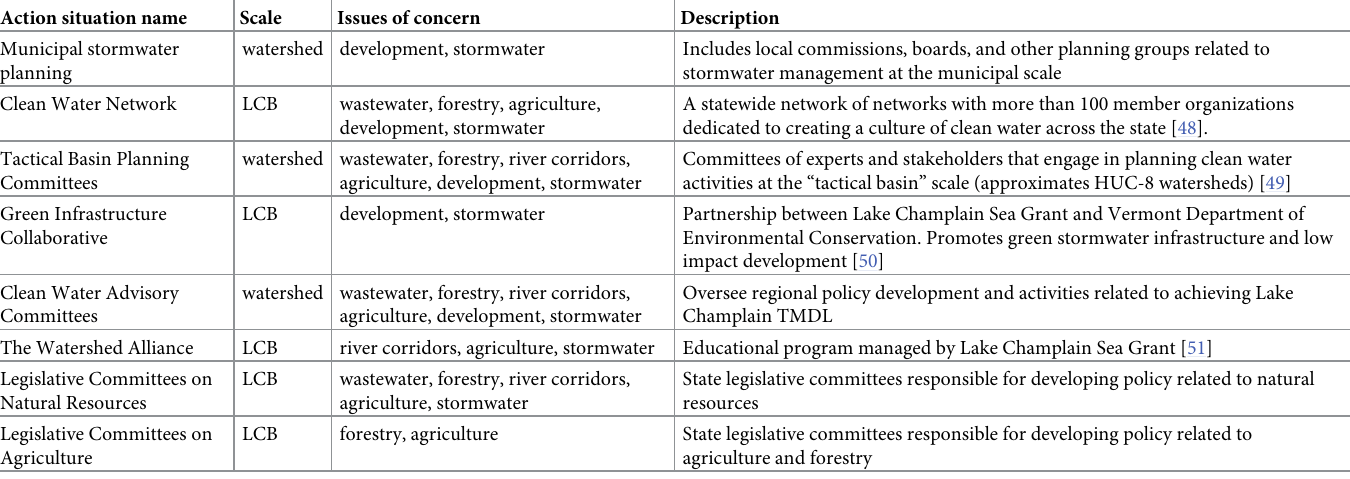
Table 1. Eight action situations related to water quality management in the Lake Champlain Basin. Scale and issues coded by